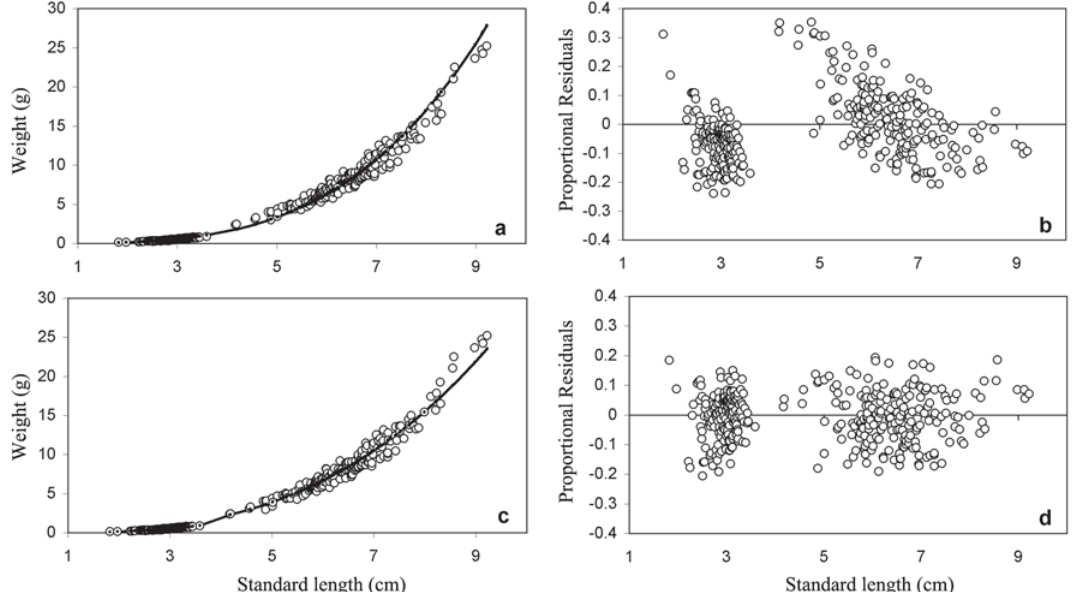
Fig. 1. Weight/length relationship for Astyanax jacuhiensis ( a ); proportional residuals resulting from Huxley´s adjustment ( b ); weight/length relationship and proportional residuals distribution according to the polyphasic growth model ( c and d , respectively).